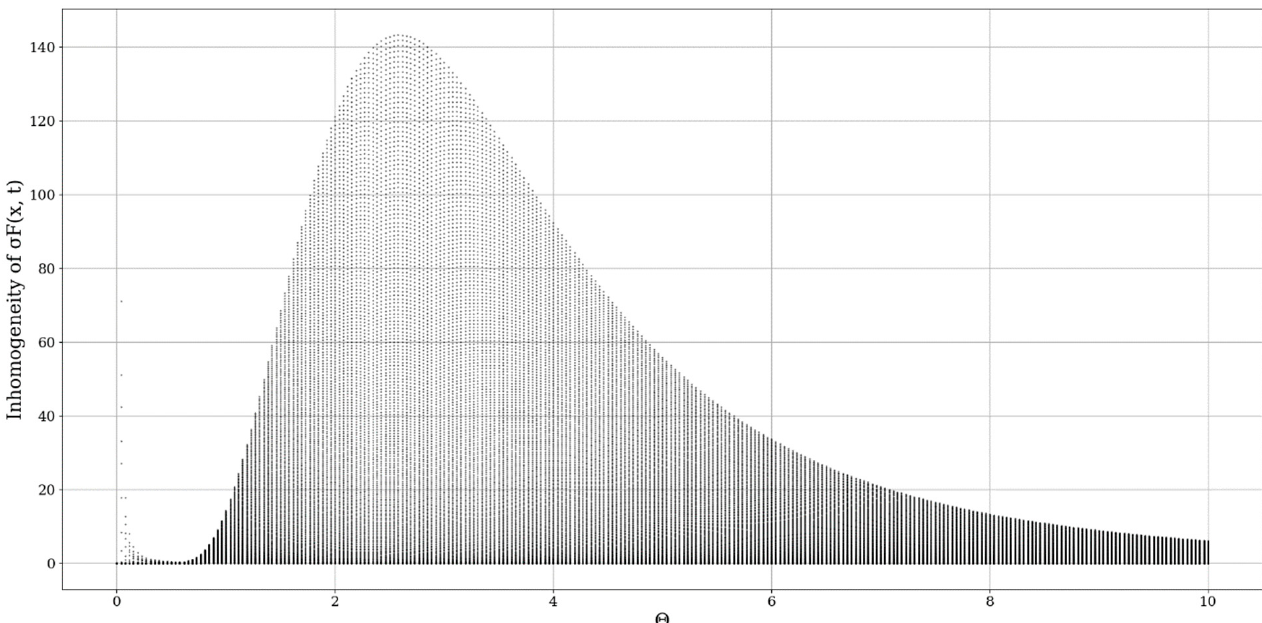
(cid:104)| σ | (cid:48) 2 (cid:105) example plot with θ as control parameter; ξ = 3; µ = 0.5. Figure 9. 〈|σ (cid:2890) (cid:3364)(cid:3364)(cid:3364)| (cid:4593)(cid:2870) 〉 example plot with θ as control parameter; ξ = 3 ; μ = 0.5 . Figure 9. F